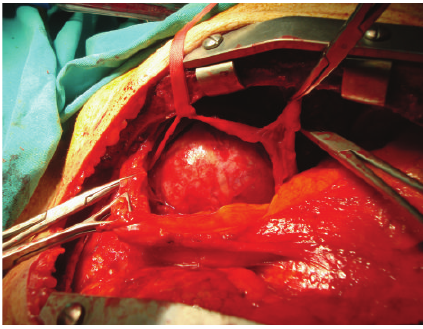
Figure 9: S-100 positivity in atypical